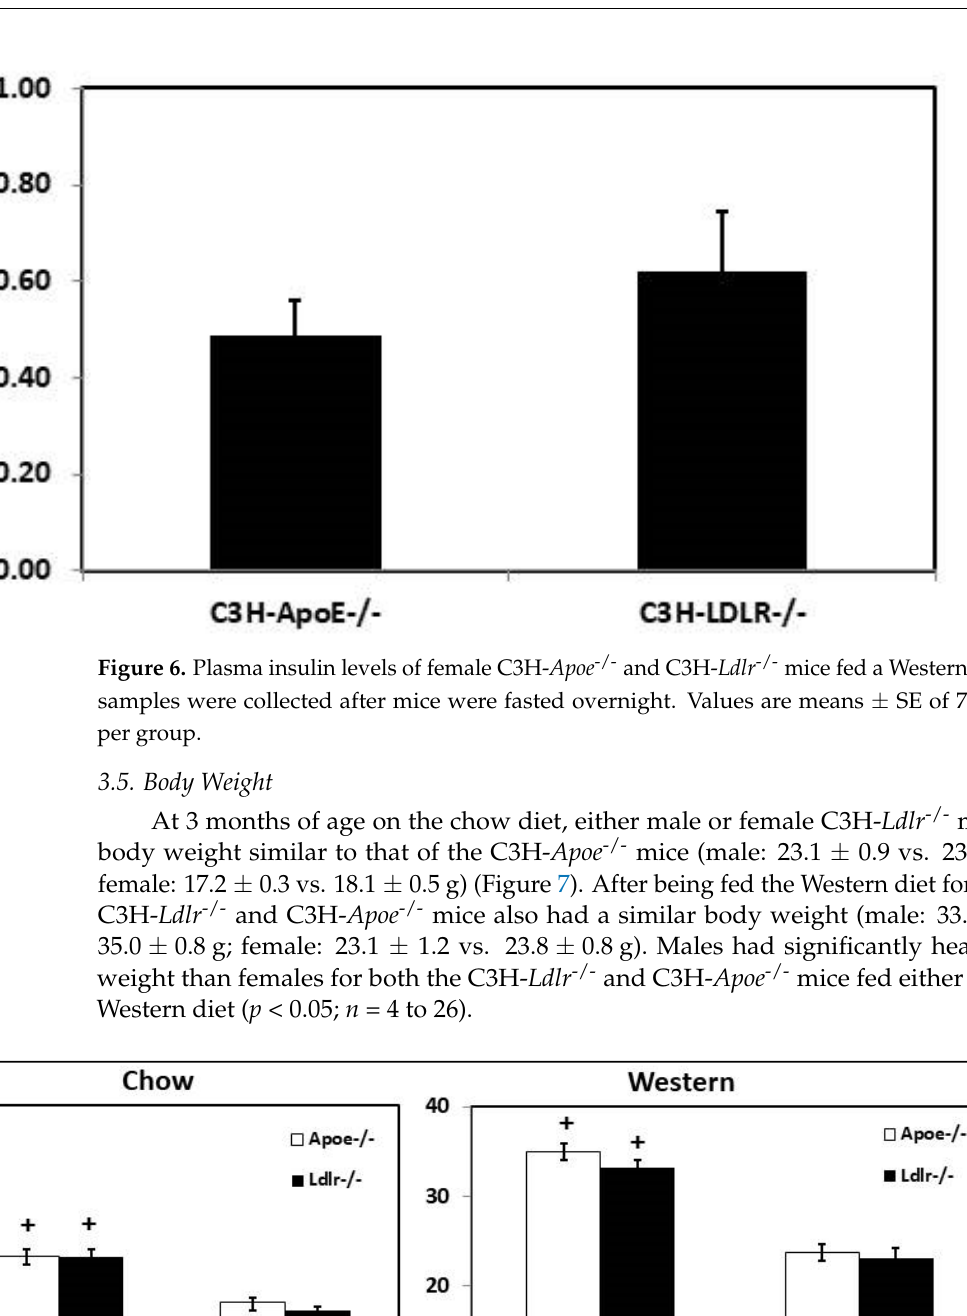
7 of 13 Figure 5. Insulin tolerance test (ITT) for male and female C3H- Apoe -/- and C3H- Ldlr -/- mice fed a Western diet. Non-fasted mice were intraperitoneally injected with 0.75 U/kg of insulin. Blood glu- cose concentrations were determined with a glucometer using blood taken from cut tail tips at the indicated time points ( A , B ). Values are means ± SE of 4 to 20 mice per group. * p < 0.05 vs. Apoe -/- mice. ( C , D ), Glucose concentrations were expressed as % of the basal.